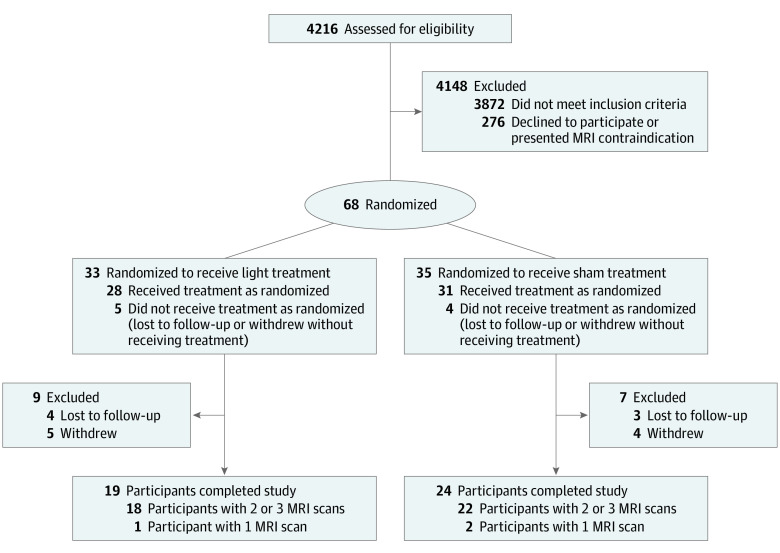
Patient Flow DiagramMRI indicates magnetic resonance imaging.